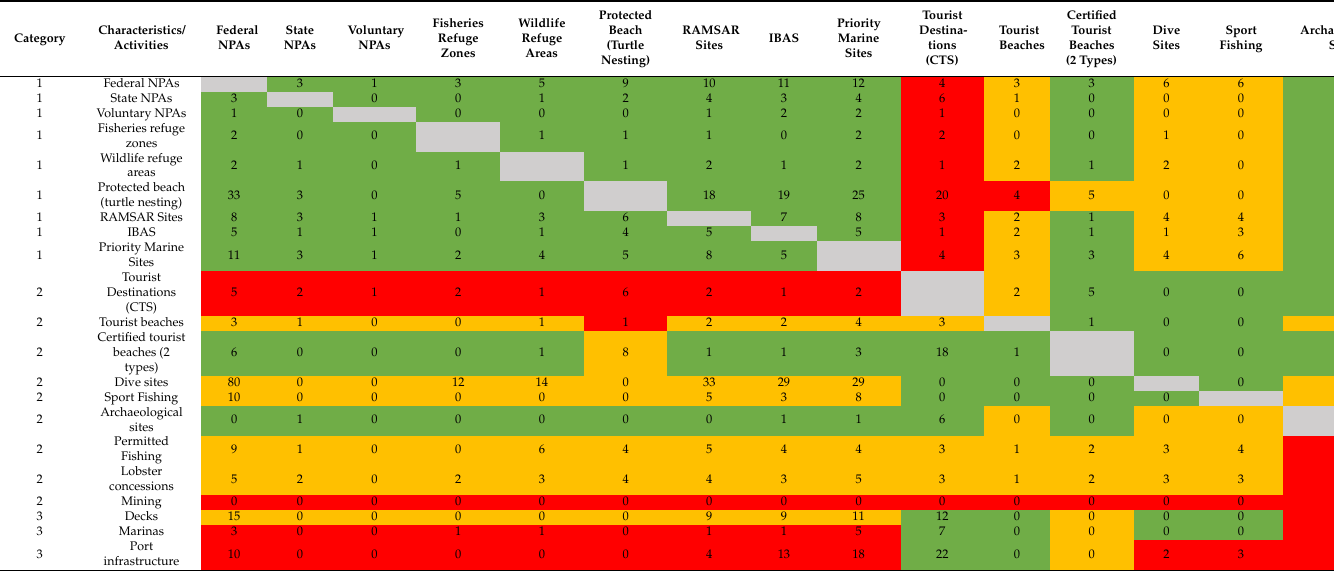
Table 7. Interaction between compatibility (colours) and the number of spatial intersection (represented by “a” in Figure 4) between characteristics/activities. The colours represent the degree of compatibility between the objectives of the characteristics/activities. Compatible objectives (green), Poorly compatible objectives (yellow) and Incompatible objectives (red). Categories: 1: Natural Protected Areas and Environmental zones, 2, Human activities, 3. Infra